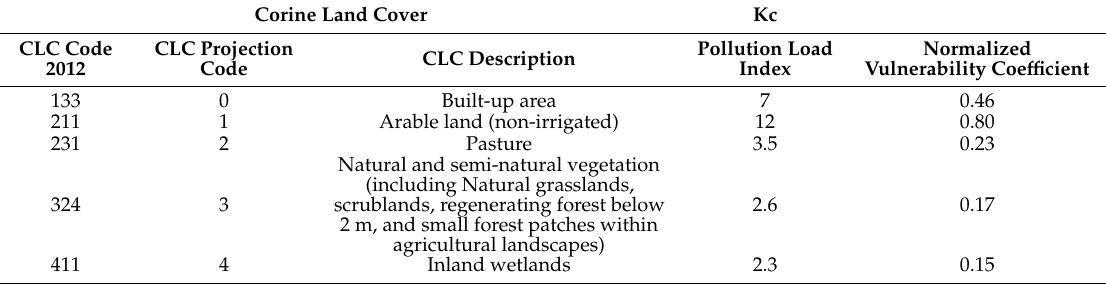
Table 3. Corine land cover classes and relative pollution load index applied to future scenarios, in the Piedmont